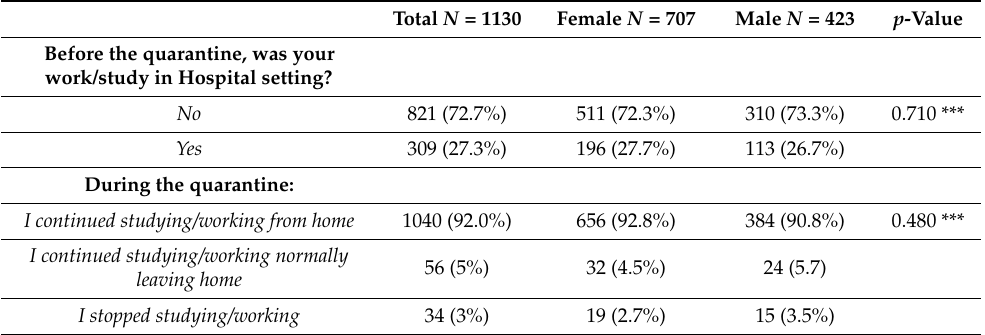
Table 3. The quarantine’s effect on job activity of the university population and stratification by gender.